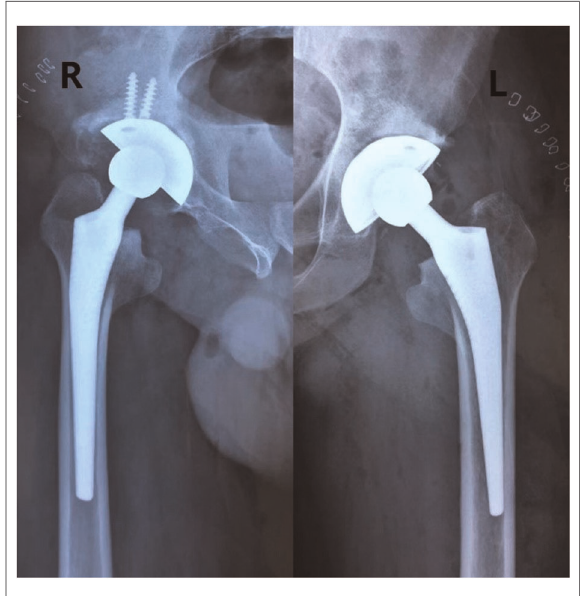
FIGURE 3 Patient ’ s hip x-ray 1 month after surgery. (Figure notes: X-rays showed that the bilateral hip prostheses were well positioned, with no obvious dislocation or other adverse